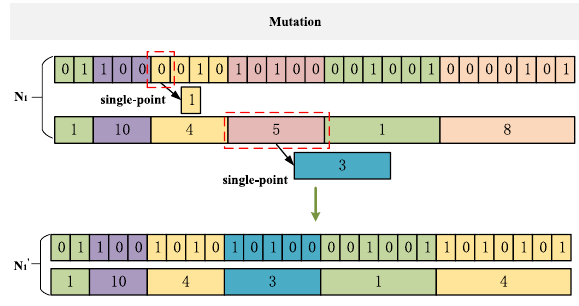
Fig. 7 Illustrative example of the proposed probability-level-based mutation operator of N